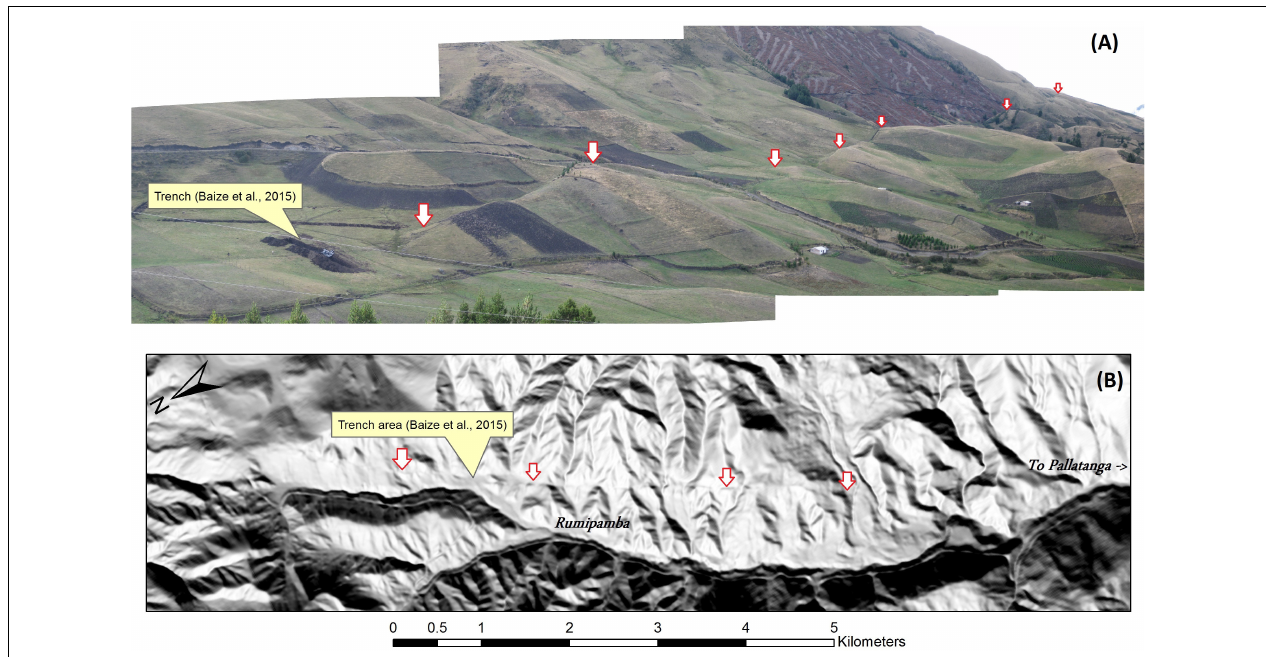
FIGURE 2 | Illustration of the signature of an active portion of the Pallatanga fault on a field panorama (A) and on the corresponding 4 m resolution DEM (B) . On the left of the photo in (A) , one can observe one of the trenches dug in 2009–2010 and presented in Baize et al. (2015). The fault trace is easily inferred from an uphill-facing and counter-slope scarp, matching a deflection in perpendicular morphological features (channel incisions, ridges). See Figure 3 and Supplementary Figure S8 for